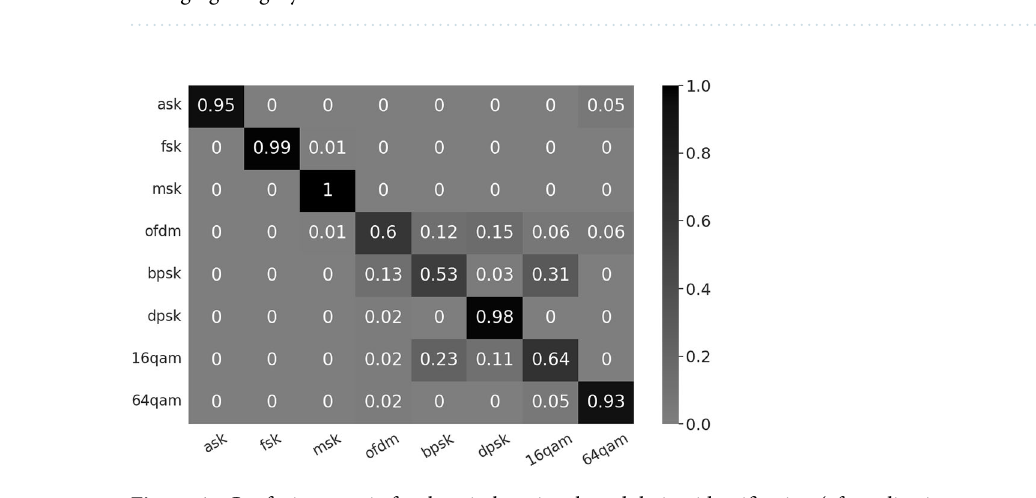
Figure 6. Confusion matrix for the wireless signal modulation identification (after adjusting